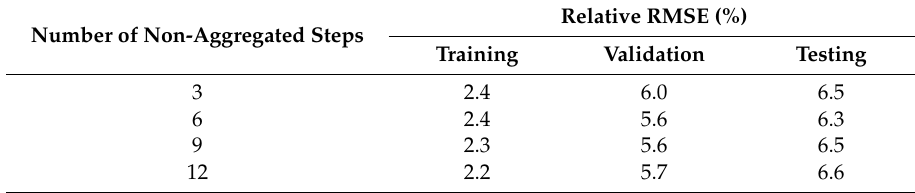
Table 4. Relative RMSE as a function of the number of non-aggregated steps.